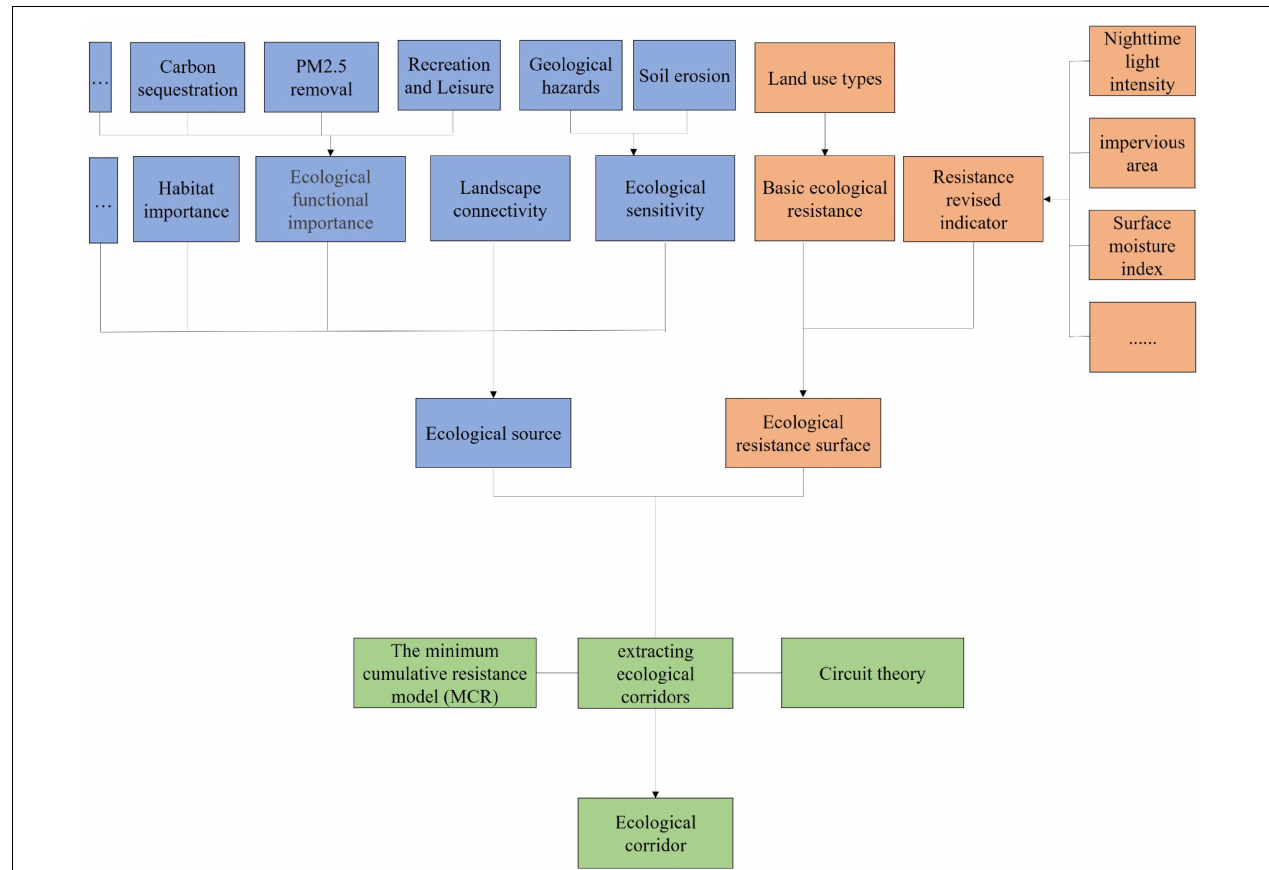
FIGURE 1 | The basic research paradigm of ecological network construction (blue boxes, identifying ecological sources; orange boxes, constructing ecological resistance surfaces; green boxes, extracting ecological